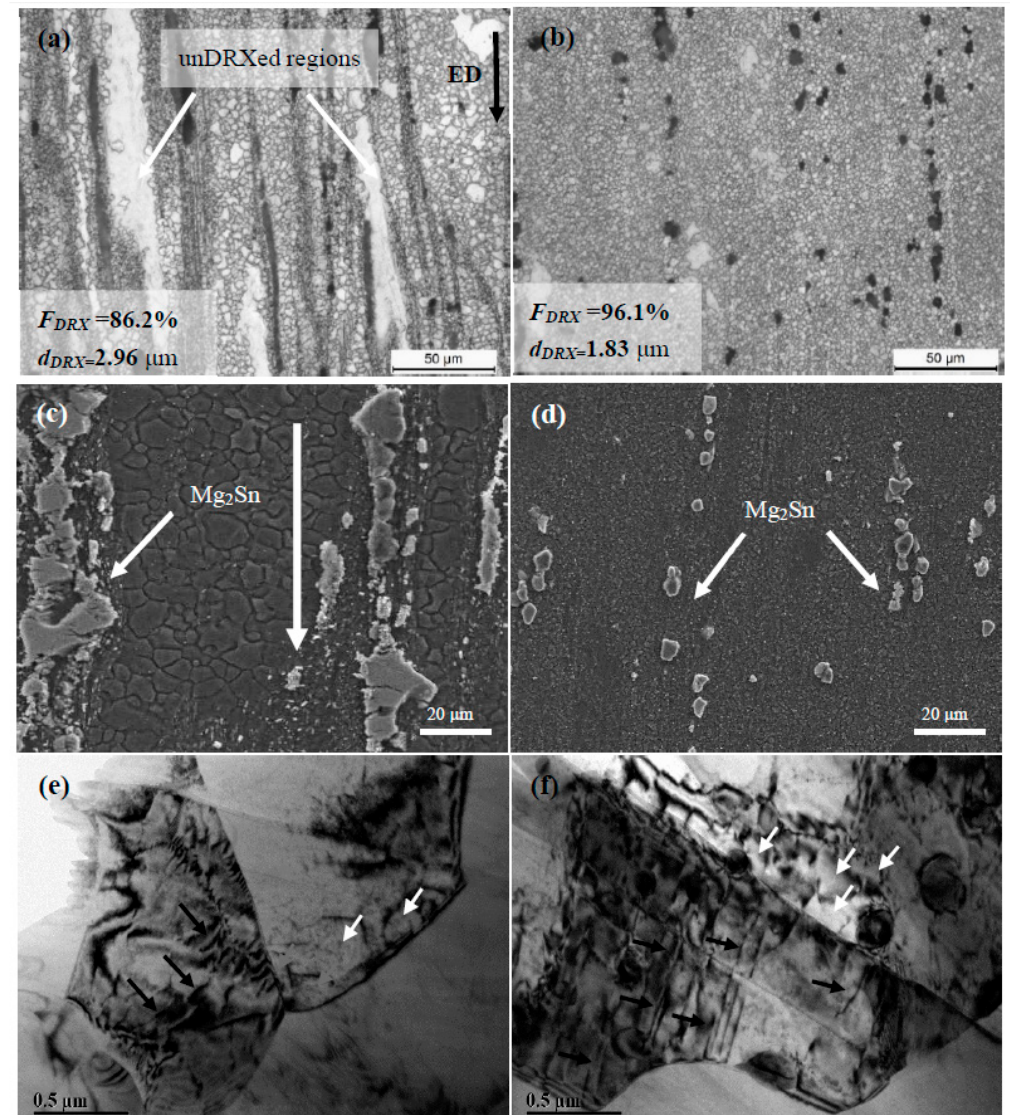
Figure 2. OM, SEM-SE and TEM images of extruded TZA822 alloys: ( a , c , e ) without T4 and ( b , d , f ) with T4, respectively.